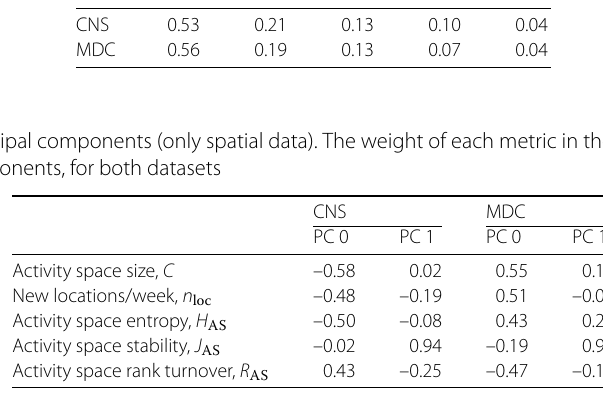
Table 10 Variance explained by principal components (only spatial data). The fraction of variance explained by each principal component for the CNS and MDC dataset PC 0